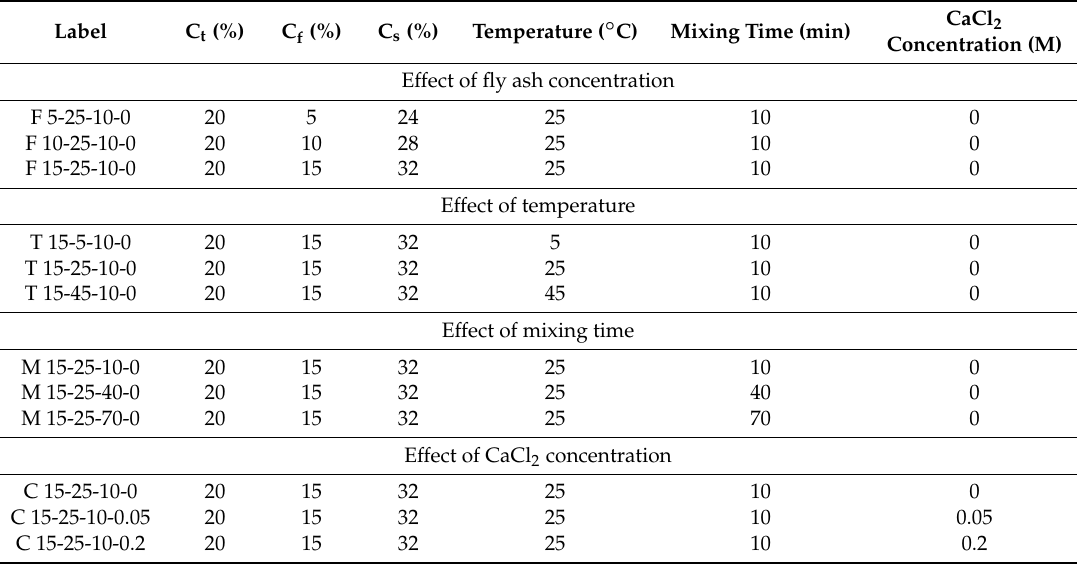
Table 1. Summary of mixture constituents for rheological measurement.